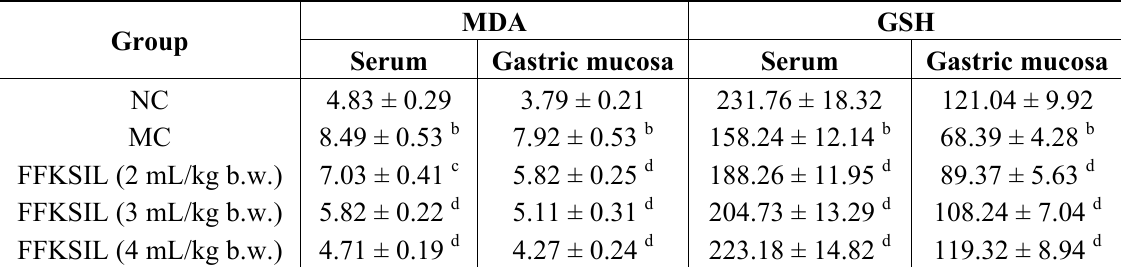
Table 4. Effect of FFKSIL treatment on serum and gastric mucosa MDA and GSH levels. Group